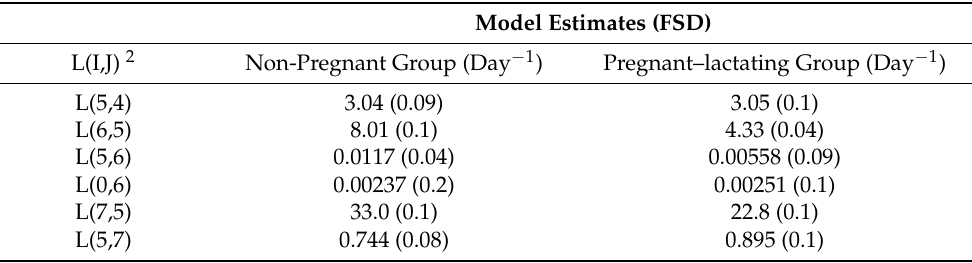
Figure 4. Fraction of administrated dose in plasma (FD p ) versus time (d) after oral delivery of 3 H-labeled retinol in one representative pregnant–lactating rat. Solid triangles are observed data; the solid line represents the model-predicted fit; the dashed line indicates the times of perturbation introduced in modeling: the first dashed line (d 21) represents the beginning of mating, the second dashed line (d 31) represents early pregnancy, the third dashed line (d 36) represents late pregnancy, and the fourth dashed line (d 45) represents the beginning of lactation. Table 3. Fractional transfer coefficients for the 7-compartment models of VA metabolism showing no difference between non-pregnant and pregnant–lactating rats prior to mating 1